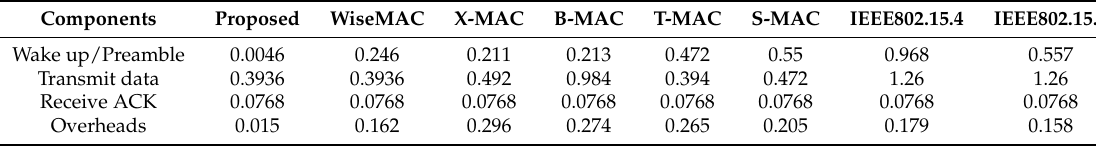
Table 6. Component-wise break down of energy consumption (units are in